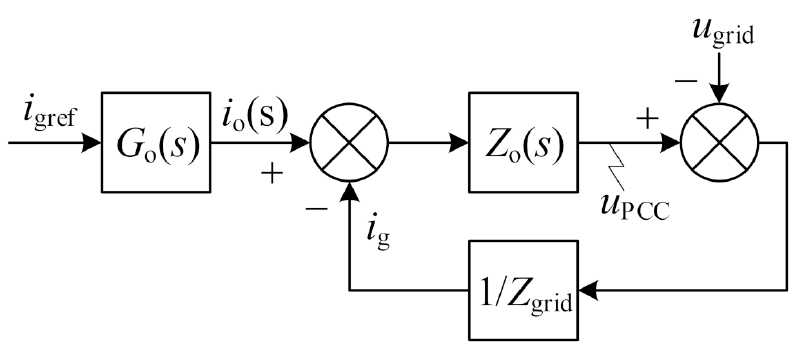
Figure 4. Output impedance model of LCL-type grid-tie